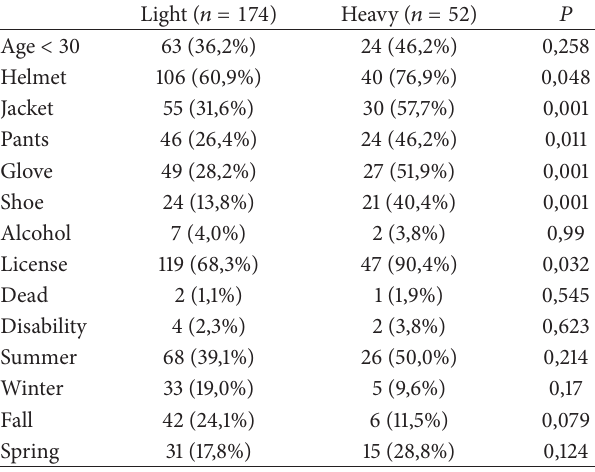
Table 1: Key features of patients and use of protective